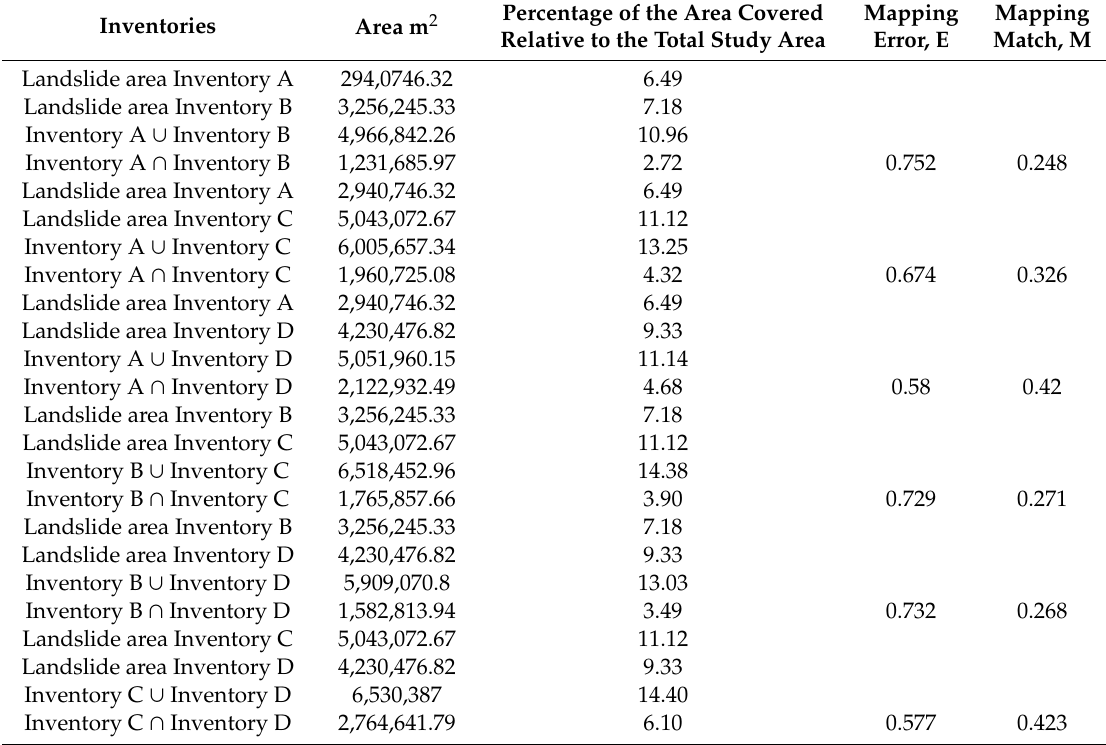
Figure 7. Comparison of inventories mapped by different interpreters. Table 3. Cartographical matching and mismatch between inventories.